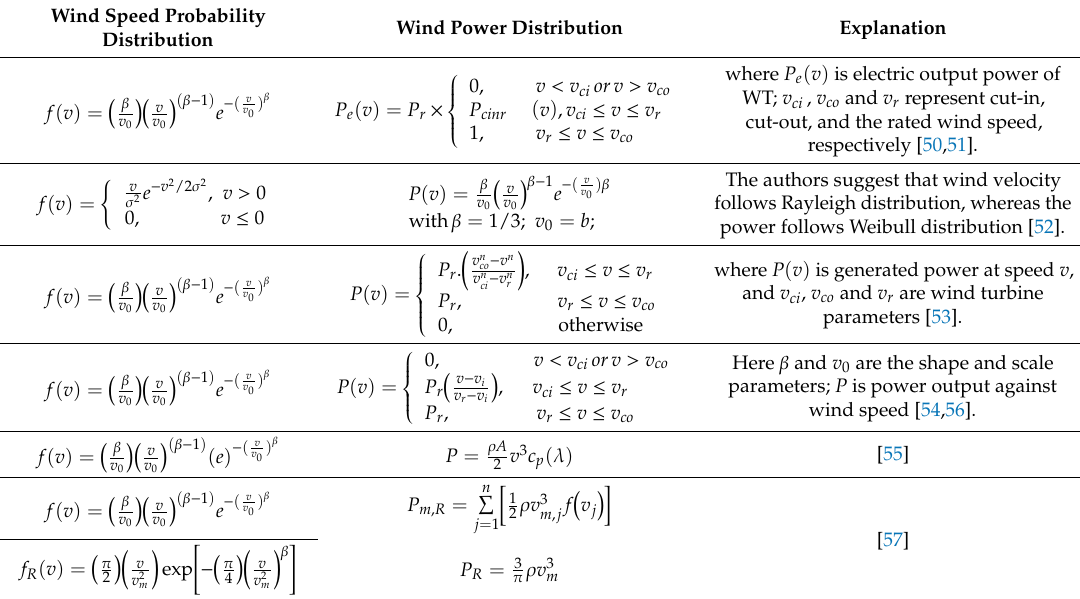
Table 2. Wind speed and power prediction with Weibull distribution (WD) and without incorporating neural networks